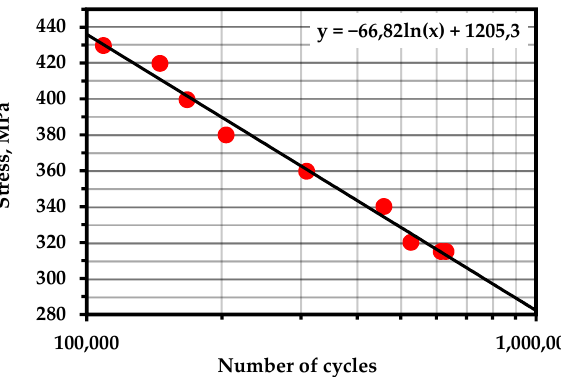
Figure A6. S–N Curve—Steel AISI 1080 (Temperature—293 К ; frequency—30 Hz; R = − 1) [101].